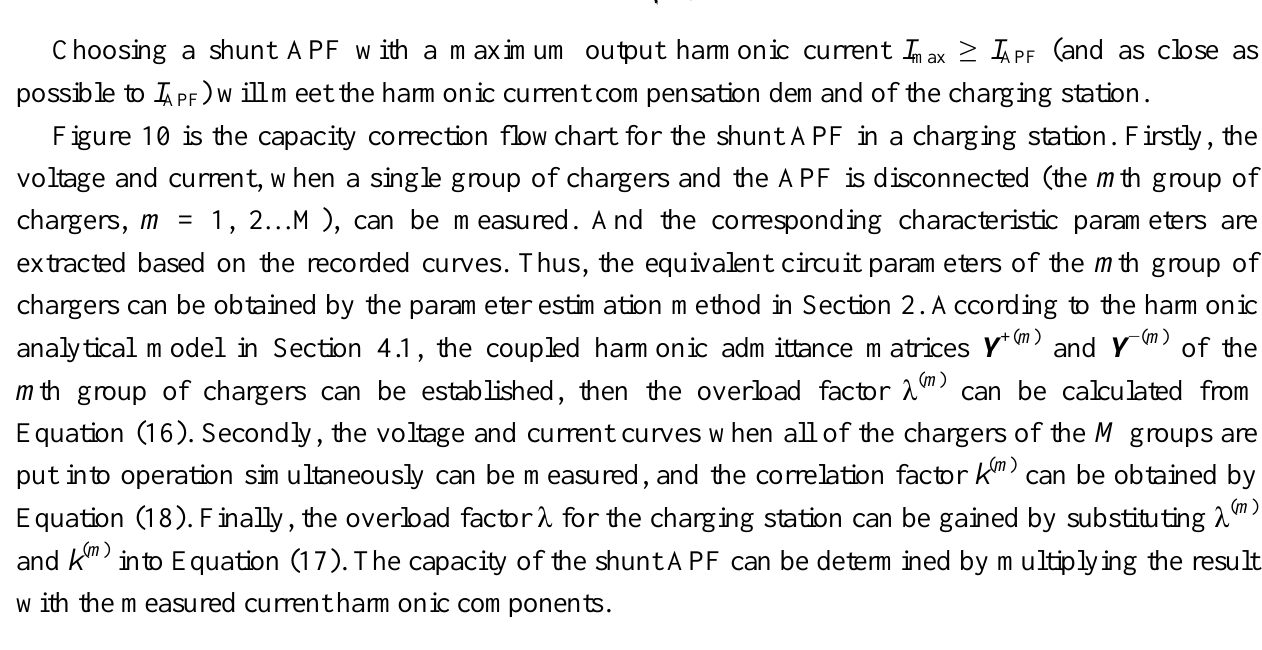
Figure 10. Flowchart for capacity correction of the shunt